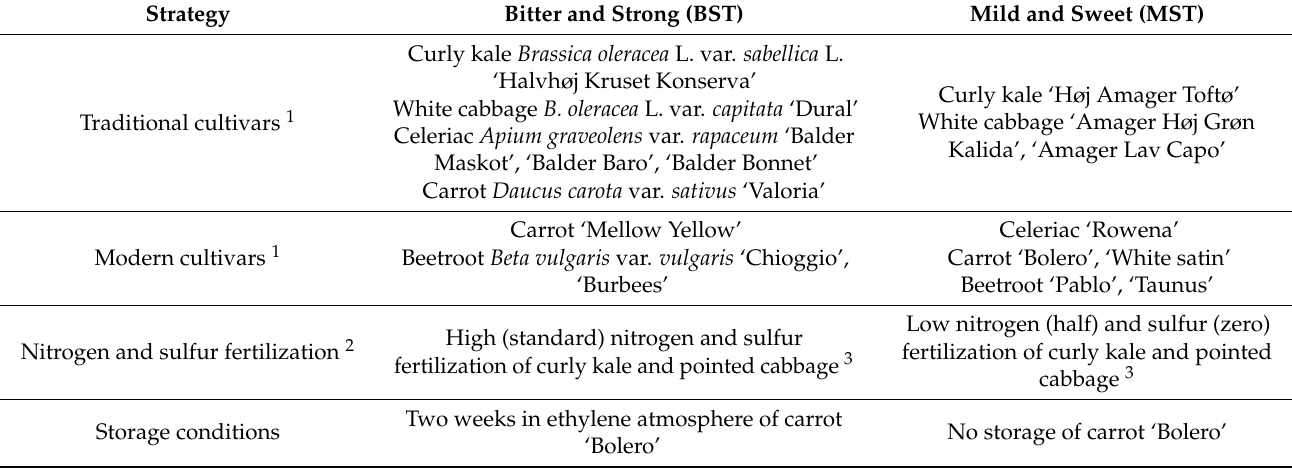
Table 1. Cropping and storage strategies to produce vegetables of bitter and strong taste (BST) or mild and sweet taste (MST) sensory